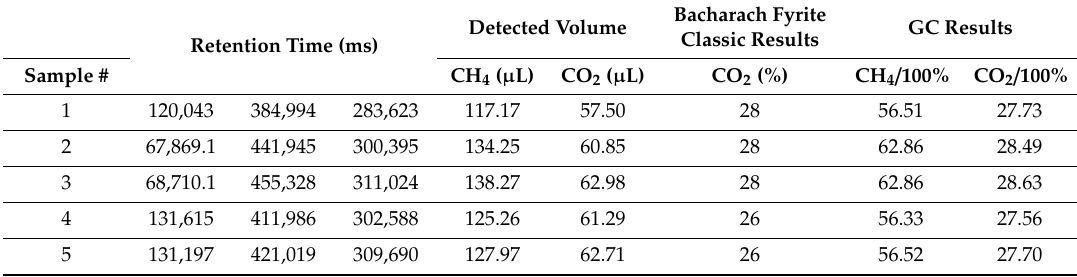
Table 4. Comparative table of methane content between data collected by Bacharach Fyrite Classic Combustion Analyzers and gas